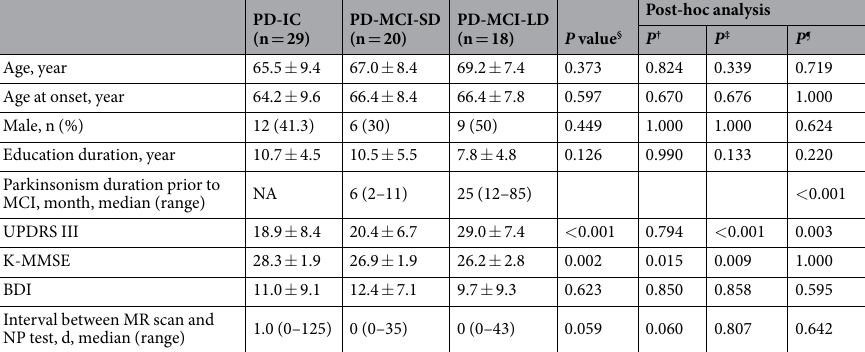
Table 1. Demographic and clinical characteristics of the PD-IC group and PD-MCI groups according to the duration of parkinsonism before MCI diagnosis. Abbreviations: BDI = Beck Depression Inventory; K-MMSE = the Korean version of the Mini Mental State Examination; MCI = mild cognitive impairment; n = number; NP test = neuropsychological test; PD-IC = Parkinson’s disease with intact cognition; PD- MCI-SD = Parkinson’s disease with a shorter duration of parkinsonism before mild cognitive impairment diagnosis; PD-MCI-LD = Parkinson’s disease with a longer duration of parkinsonism before mild cognitive impairment diagnosis; UPDRS III = Unified Parkinson’s Disease Rating Scale Part III. Note.-Unless otherwise indicated, data are means ± standard deviations. § P values for comparison among the 3 groups; † P values for comparison between the PD-IC and PD-MCI-SD groups; ‡ P values for comparison between the PD-IC and PD- MCI-LD groups; ¶ P values for comparison between the PD-MCI-SD and PD-MCI-LD